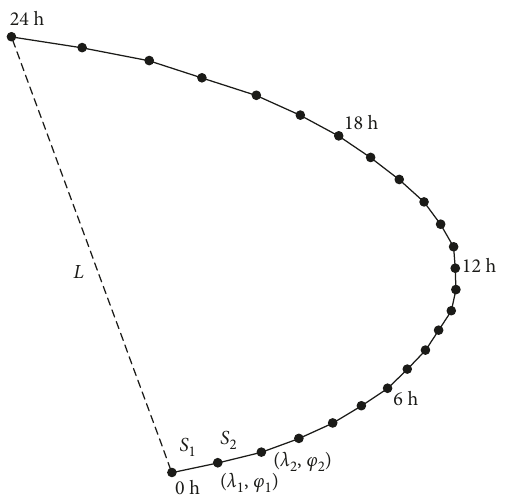
Figure 1: Backward trajectory showing the resulting transport distance L and the distance S i between pairs of consecutive tra- jectory